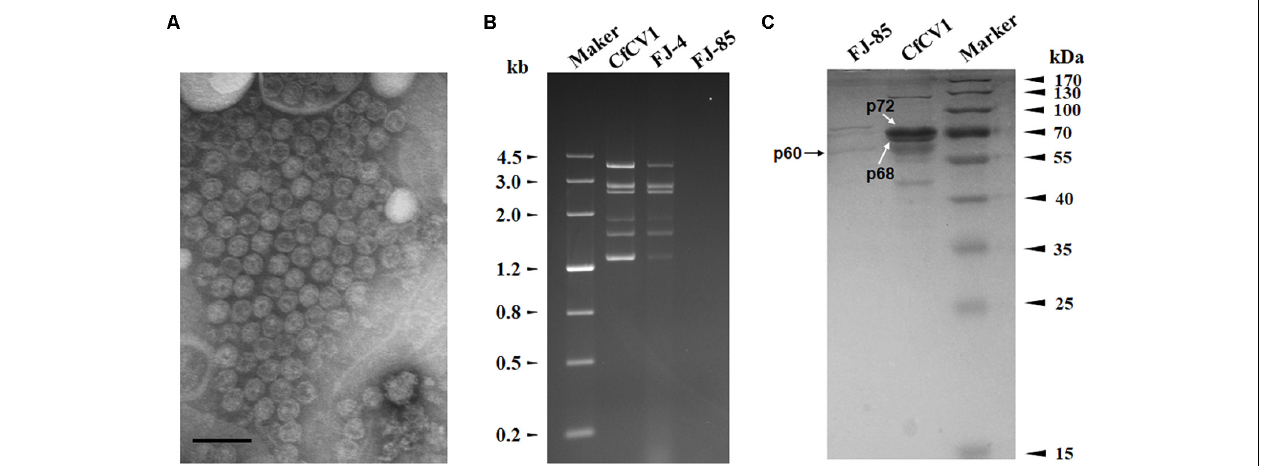
FIGURE 5 | VLP composition of CfCV1. (A) TEM observation of the VLPs. (B) 1.2% agarose gel electrophoresis in TAE buffer for 16 h at 50 V of the dsRNA profiles from mycelia and VLPs. (C) 10% SDS-PAGE gel-electrophoresis analysis of the protein components of the purified VPs from CfCV1-infected strain (lane CfCV1). The arrows showed the 60, 68, and 72 kDa proteins. The VLPs purified from the strain FJ-85 were analyzed using the same method (lane FJ-85). The protein markers were used to estimate the molecular weight of the protein bands. The scale bar represents 50 nm.